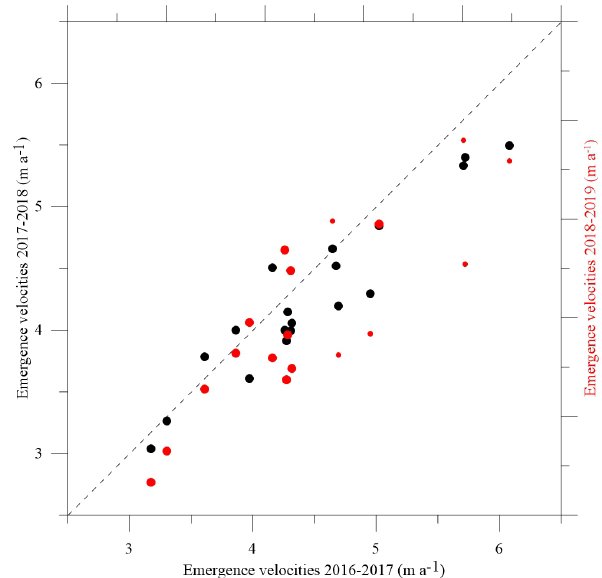
Figure 7. Comparison of emergence velocities between the years 2016/2017, 2017/2018 and 2018/2019. The black dots correspond to the comparison between the 2016/2017 and 2017/2018 periods. The red dots correspond to the comparison between the 2016/2017 and 2018/2019 periods. The red small dots correspond to the stakes that were set up in 2018 at distances of more than 25m from their initial